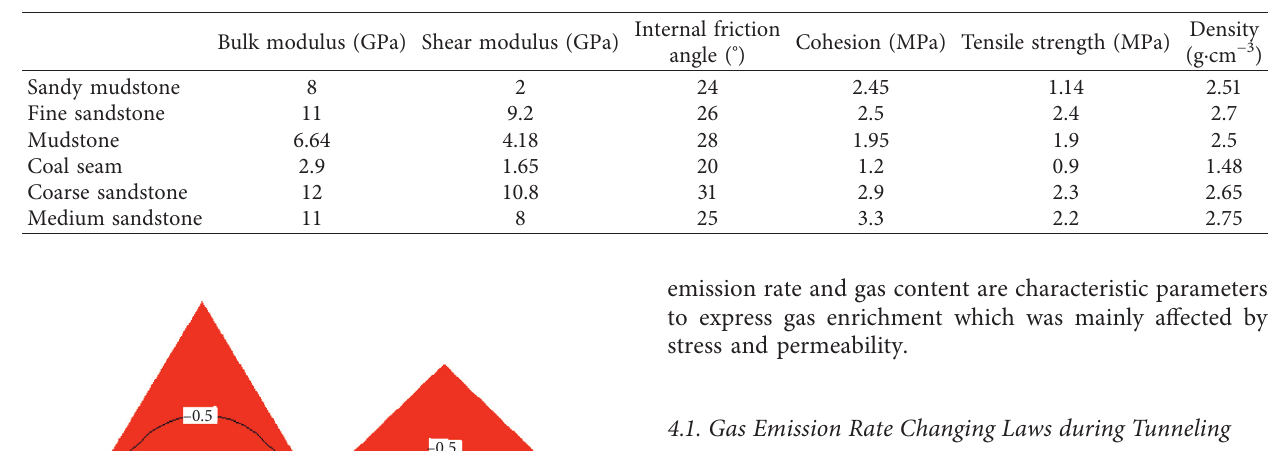
Table 1: Calculation parameters.